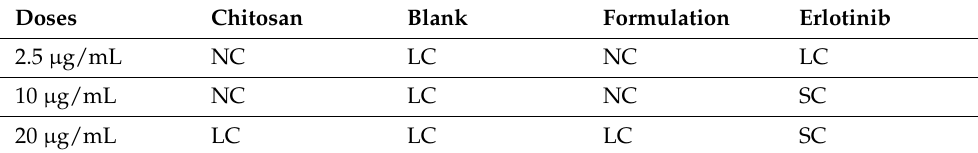
Table A3. Toxicity